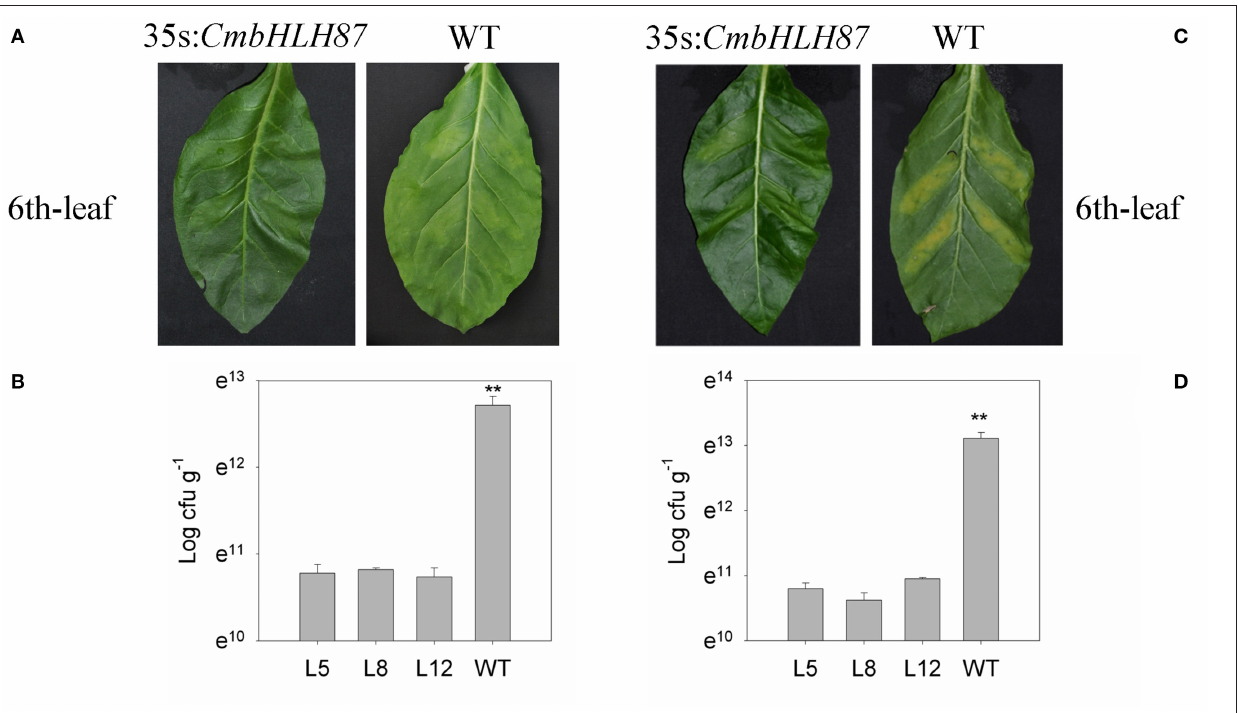
FIGURE 6 | The resistance of CmbHLH87 in tobacco plants to bacterial wilt and scab. (A) Pathogens symptoms of the 6th-upper leaf injection sites was injected with bacterial wilt bacteria with a needle-removed syringe; (B) concentration bacteria of the 6th-upper leaf injection sites was injected with bacterial wilt bacteria with a needle-removed syringe; (C) pathogens symptoms of the 6th-upper leaf injection sites was injected with scab bacteria with a needle-removed syringe; (D) concentration bacteria of the 6th-upper leaf injection sites was injected with scab bacteria. Three biological triplicates were averaged and bars indicate standard error of the mean. ** denotes significant differences between wild-type (WT) and transgenic plants at p <